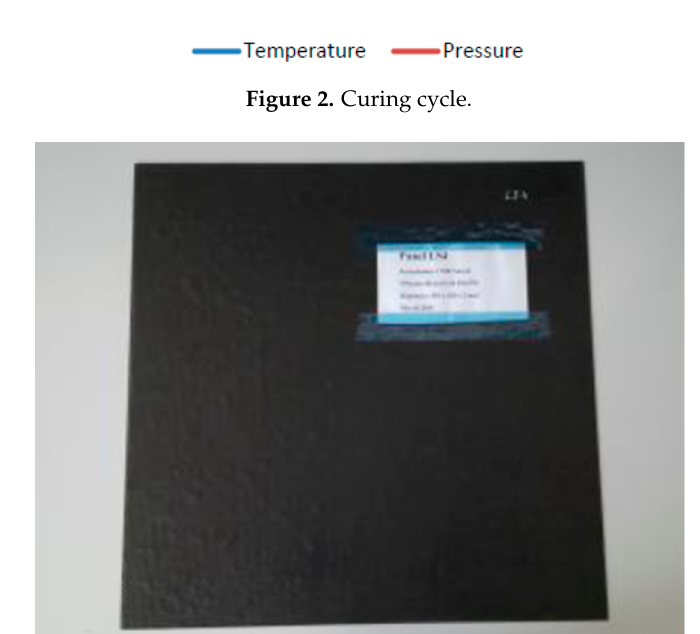
Materials 2019 , 12 , x FOR PEER REVIEW